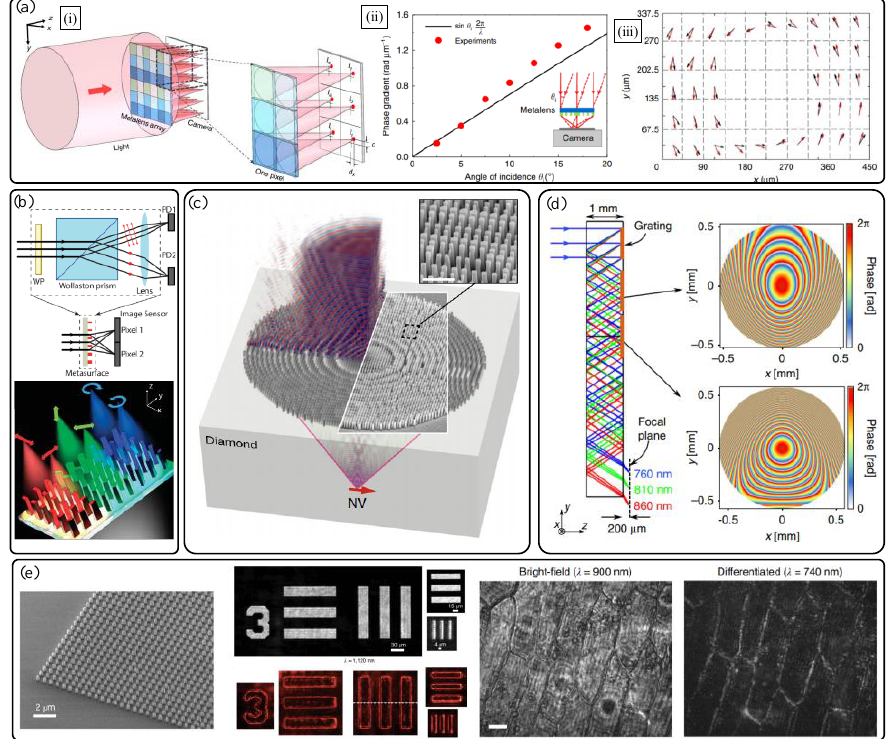
Figure 9. Various dielectric metalens sensing applications. ( a ) Micro-metalens array based polarimetric Shack-Hartmann wavefront sensor [43]. ( i ) Schematic diagram. Sensing results of ( ii ) angle of incidence and ( iii ) polarization map of azimuthally polarized Bessel beam. ( b ) Scheme of imaging polarimeter using micro-metalens array [44]. ( c ) Efficient quantum emitter sensing with immersion metalens [45]. ( d ) Folded meta-optics for compact spectrometer [46]. ( e ) Wavefront differentiation for edge detection using a Laplacian metasurface [47]. Fabrication result ( left ), edge detection of resolution target ( center ) and biological tissue ( right ). Reprinted with permission ( a ) from [43] Copyright 2018 Springer Nature, ( b ) from [44] Copyright 2018 American Chemical Society, ( c ) from